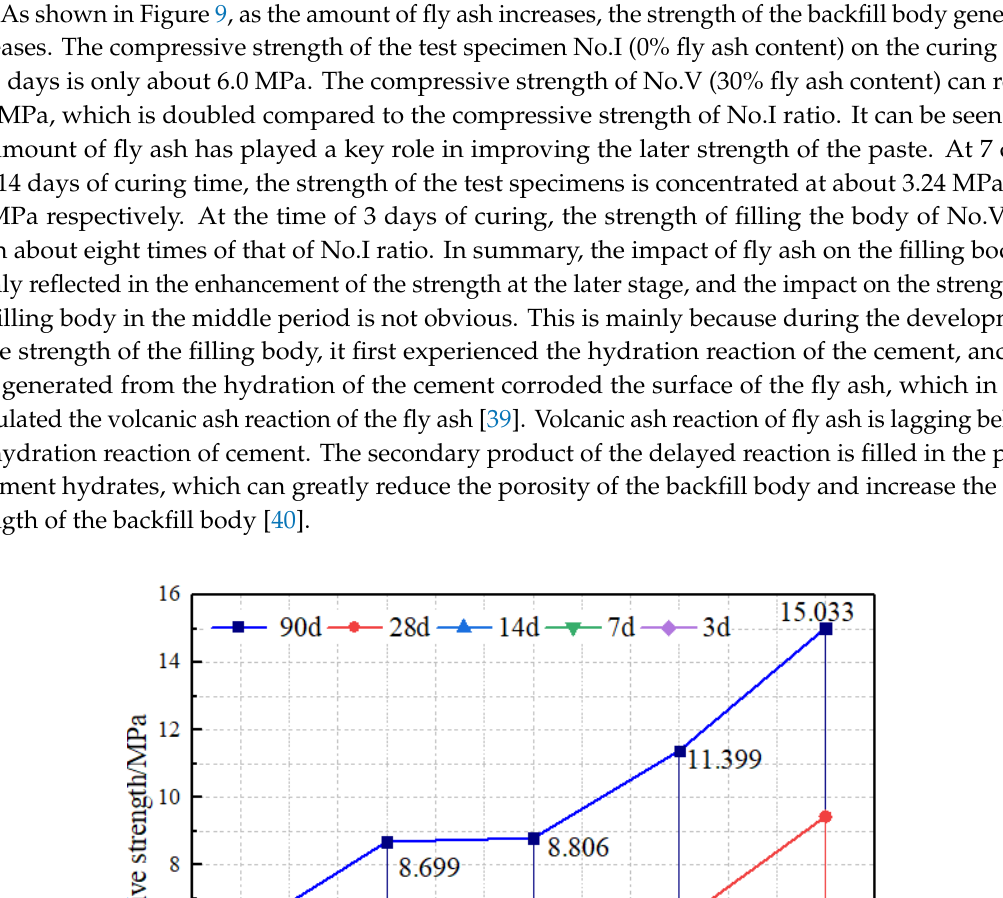
Figure 8. Rheological curve at constant shear rate.